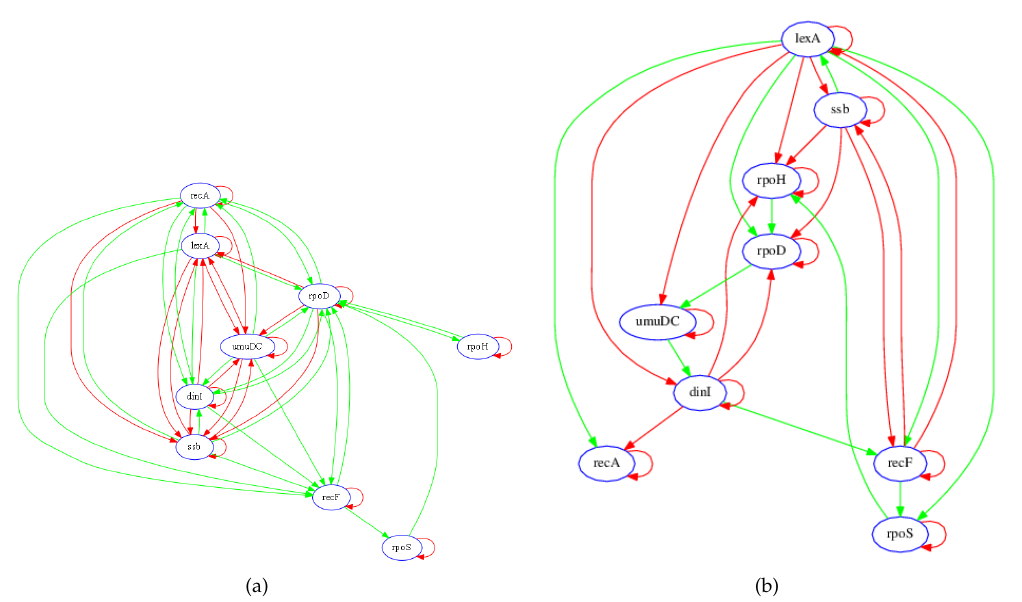
Figure 2. Known and recovered GRN for SOS pathway in E. coli . ( a ) Diagram of interactions in the SOS network. DNA lesions caused by mitomycin C (MMC) ( blue hexagon ) are converted to single-stranded DNA during chromosomal replication. Upon binding to ssDNA, the RecA protein is activated (RecA*) and serves as a coprotease for the LexA protein. The LexA protein is cleaved, thereby diminishing the repression of genes that mediate multiple protective responses. Green arrows denote positive regulation, while red arrows denote negative regulation. Adapted from [8]. ( b ) Diagram of the recovered gene regulatory network of the SOS pathway in Escherichia coli . Green arrows denote positive regulation, while red arrows denote negative